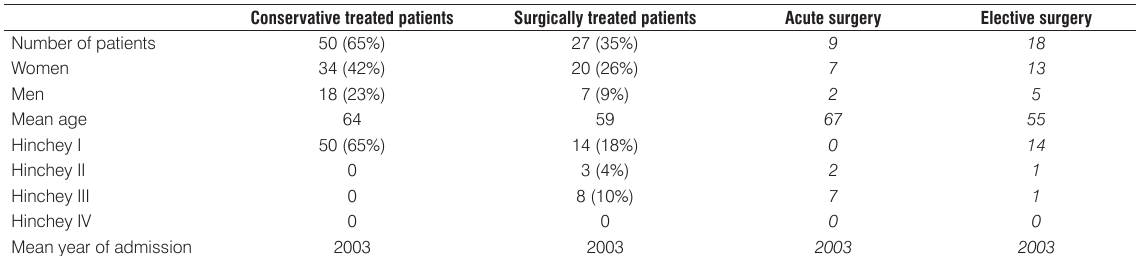
Table 1. Characteristics of the operated and non-operated patients (percents of the total number of included patients).